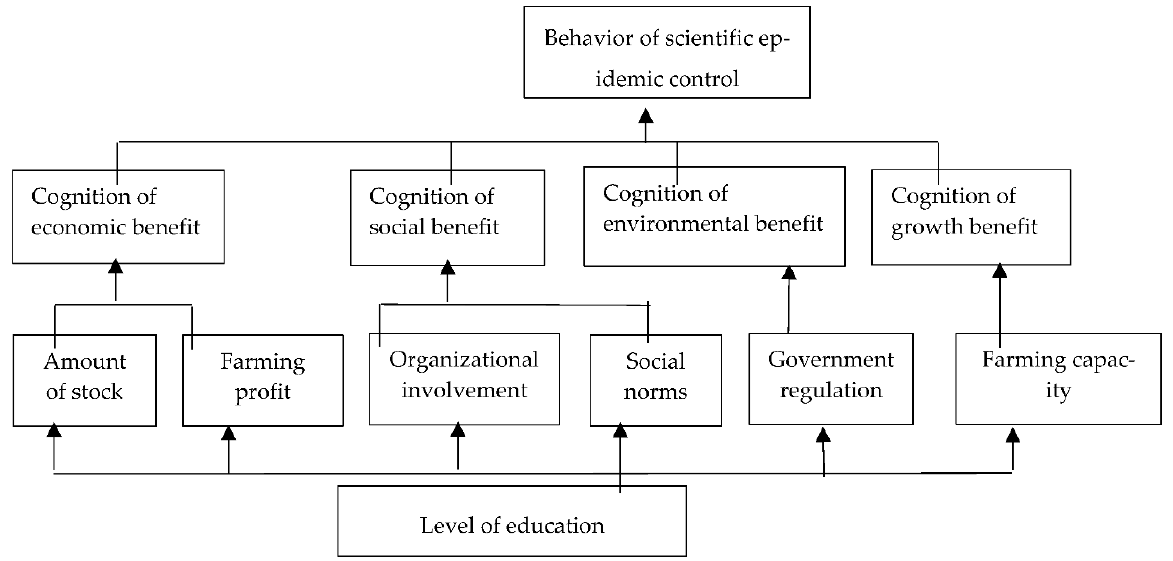
Figure 4. Correlation and Hierarchical Structure Among Influencing Factors of Scientific Epidemic Control.